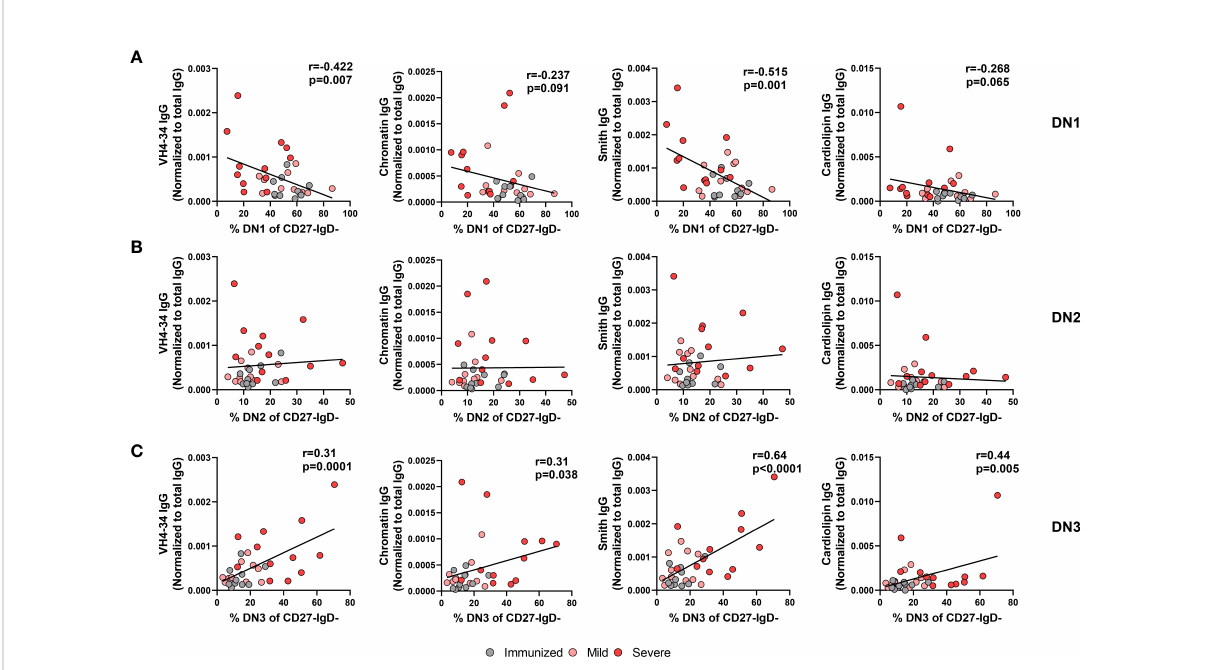
FIGURE 9 Correlation of autoreactive antibodies with changes in Double Negative subset frequencies during Severe SARS-CoV-2 infection. (A) Correlation of frequency of DN1 cells, (B) frequency of DN2 cells, or (C) frequency of DN3 cells within total double negative population (CD27-IgD-) with systemic levels of autoreactive IgG antibodies (VH4-34, Chromatin, Smith, cardiolipin) normalized to total IgG from individuals immunized against SARS-CoV-2 (N=10), and individuals with mild (N=11) or severe SARS-CoV-2 infection (N=13). Statistics: Pearson correlation, r and p values noted on